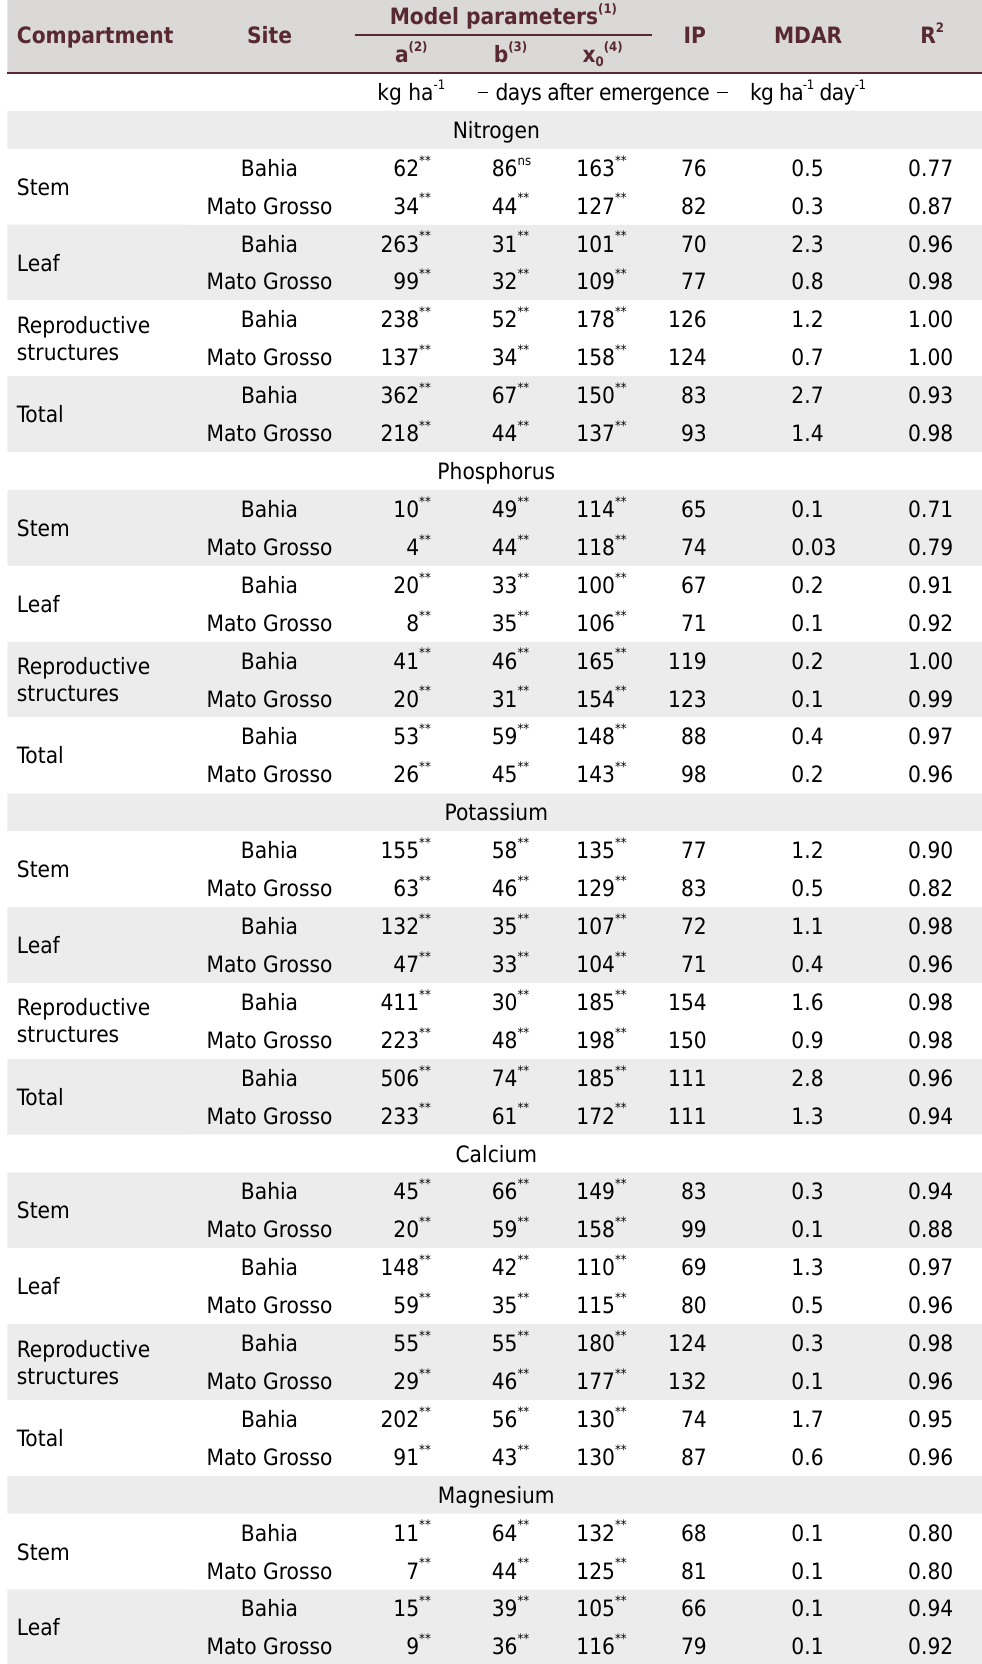
Table 3. Estimation of the model parameters fitted for accumulation of N, P, K, Ca, Mg, and S and respective inflection point (IP), maximum daily accumulation rate (MDAR), and coefficient of determination (R 2 ) Compartment